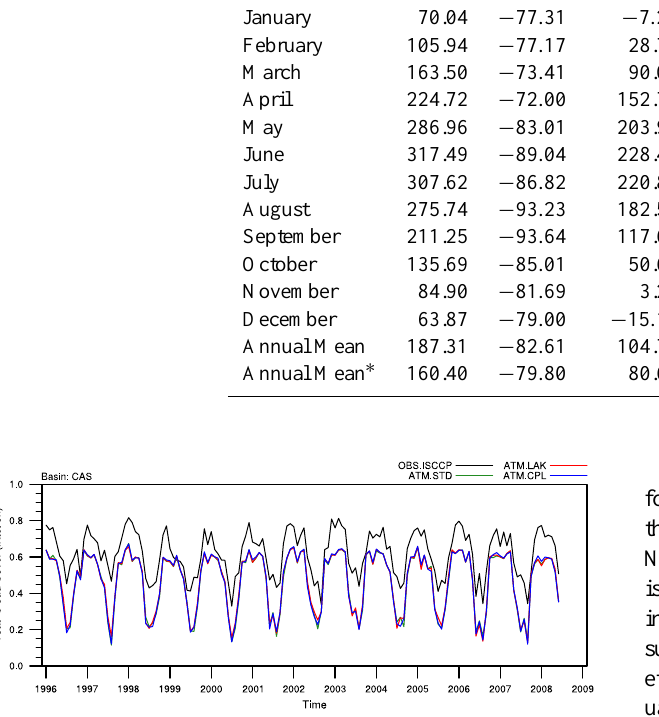
Fig. 16. Time series of monthly total cloud cover (fraction) of mod- elled (ATM.STD, ATM.LAK and ATM.CPL) and observed (ISCPP project D2 product) for the period